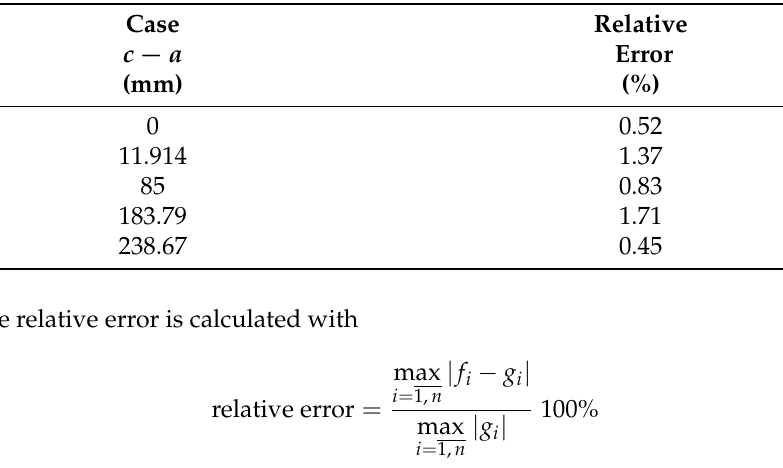
Table 1. Relative error between